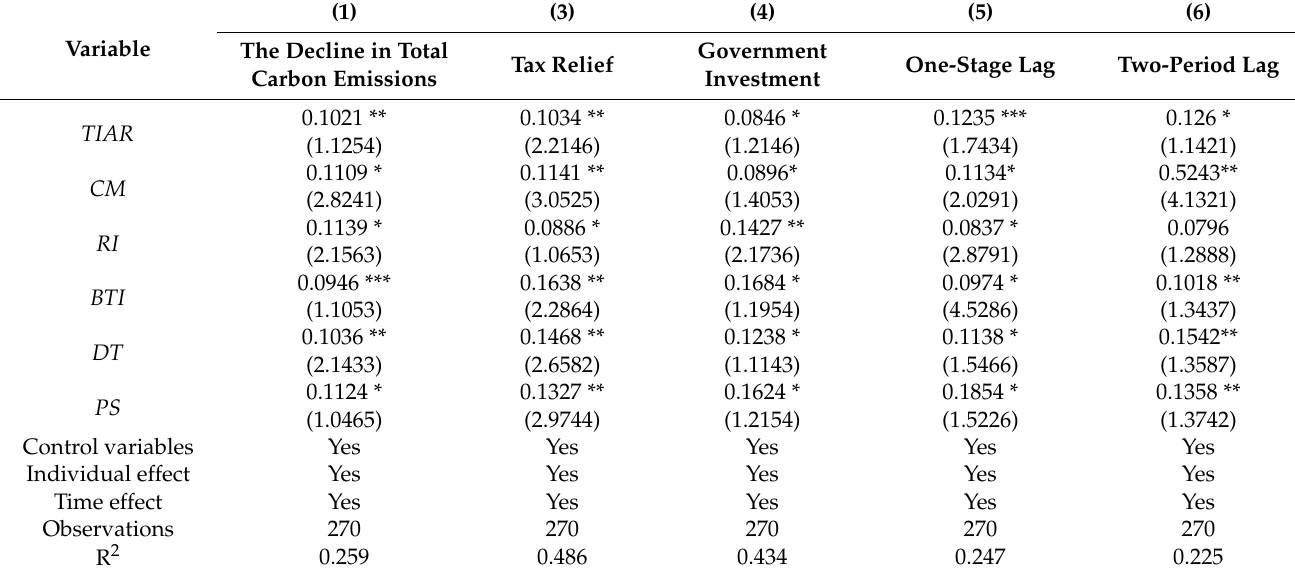
Table 7. Robustness